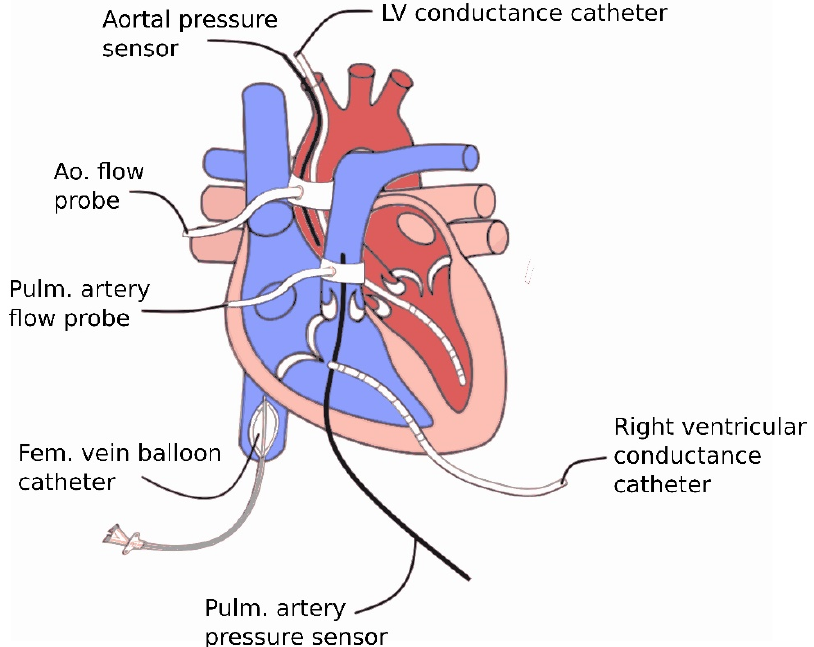
Figure 1. Instrumentation of the heart with left ventricular conductance catheter, aortal pressure sensor, aortal flow probe, pulmonary artery flow probe, femoral vein balloon catheter, pulmonary artery pressure sensor, and right ventricular conductance catheter. Figure is a modification of figure “Heart normal” by Eric Pierce [29]. The original figure can freely be published under CC BY-SA license (https://en.wikipedia.org/wiki/User:Wapcaplet, accessed on 16 March 2022).